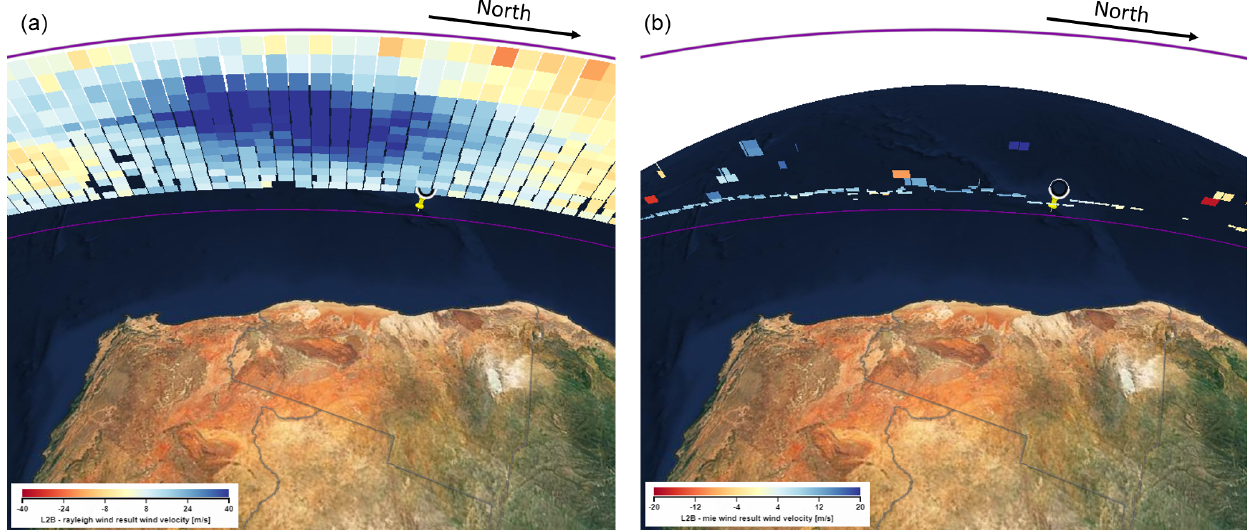
Figure 8. Aeolus HLOS winds on 6 December 2018 off the shore of Namibia. Rayleigh clear (left) and Mie cloudy (right) HLOS winds are shown for the overpass around 17:50UTC. The location of RV Polarstern is indicated by the yellow pin. The figure was created with the Aeolus visualization tool VirES